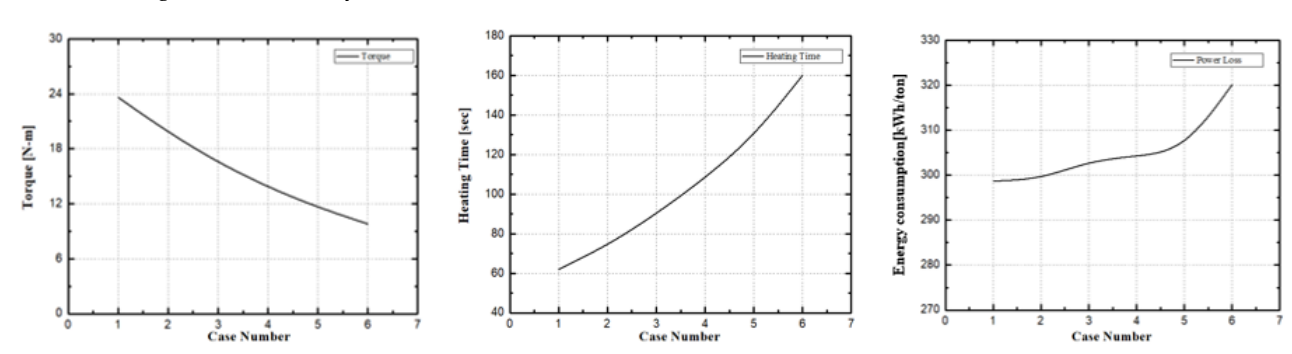
Figure 12. Analysis result with different clearances — torque, heating time, and energy consumption graphs for case model.